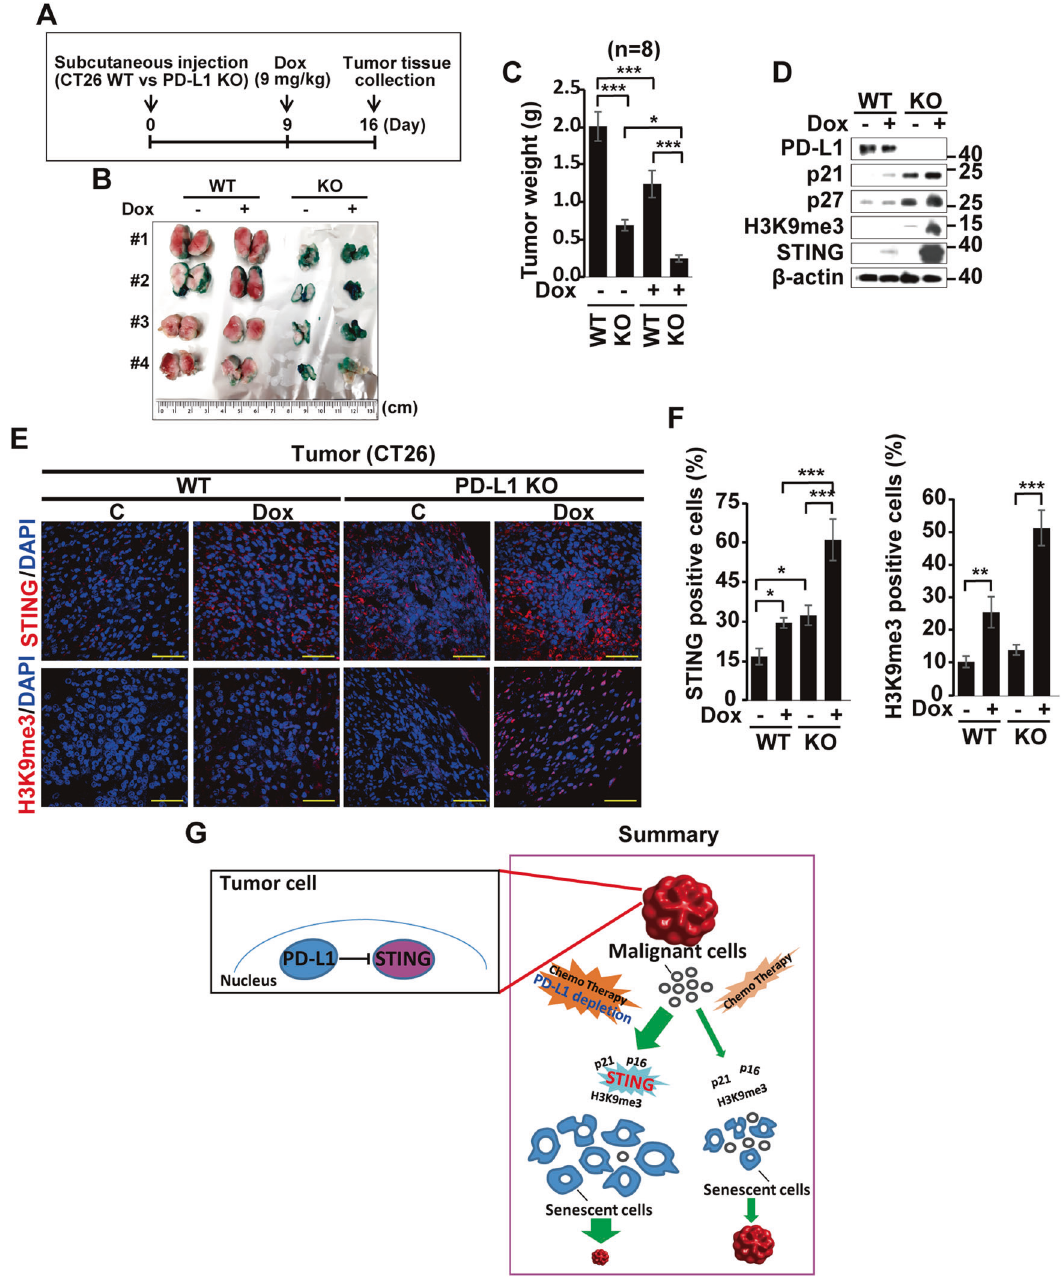
Fig. 6 PD-L1 regulates tumor growth via senescence. Tumors were generated by implanting parent or PD-L1 KO CT26 cells into mice ( A ). On day 9 after implantation, mice were administered Dox (9 mg/kg) for seven days, and tumors were excised, cut in half, and analyzed by SA- β -Gal staining ( n = 4) ( B ). Tumor weights analysis ( n = 8), ( C ), western blot analysis of tumor cell lysates for the indicated proteins ( D ), and tissue immunostaining for STING and H3K9me3 proteins were performed and quanti fi ed ( E , F ). Scale bars = 10 μ m. ( G ) A model summarizing PD-L1 targeting-induced senescence in tumor cells. While cancer cells can be suppressed by chemotherapy-induced senescence, targeting nuclear PD-L1 accelerates senescence via elevating STING expression, which exerts signi fi cant tumor suppression effects together with conventional chemotherapy. Scale bars = 100 μ m. The signi fi cance of the statistical difference was calculated using a one-way analysis of variance and Newman – Keuls. Quantitative data are expressed as means ± SD . n = 8. Quantitative data are expressed as the mean ± SD . * p < 0.05, ** p < 0.01, *** p <